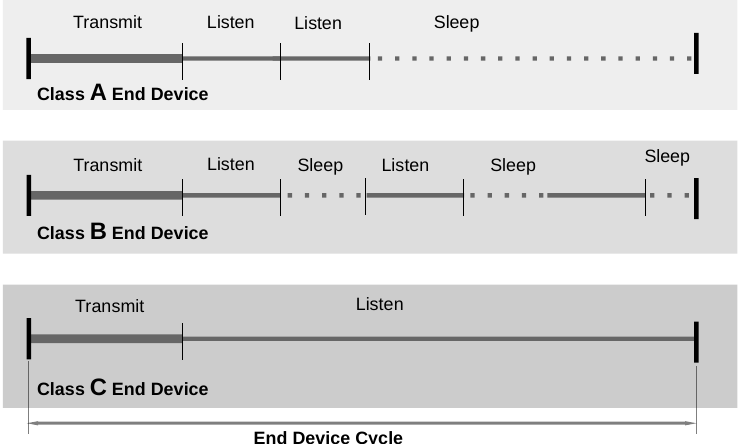
Figure 1. LoRa end devices classification